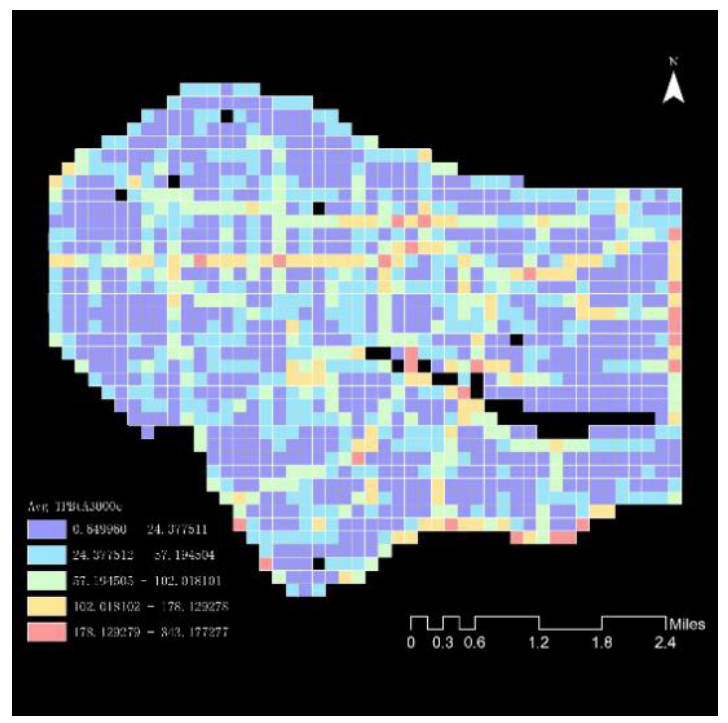
Fig. 20 Fishing net graph of regional TPBt at a radius of